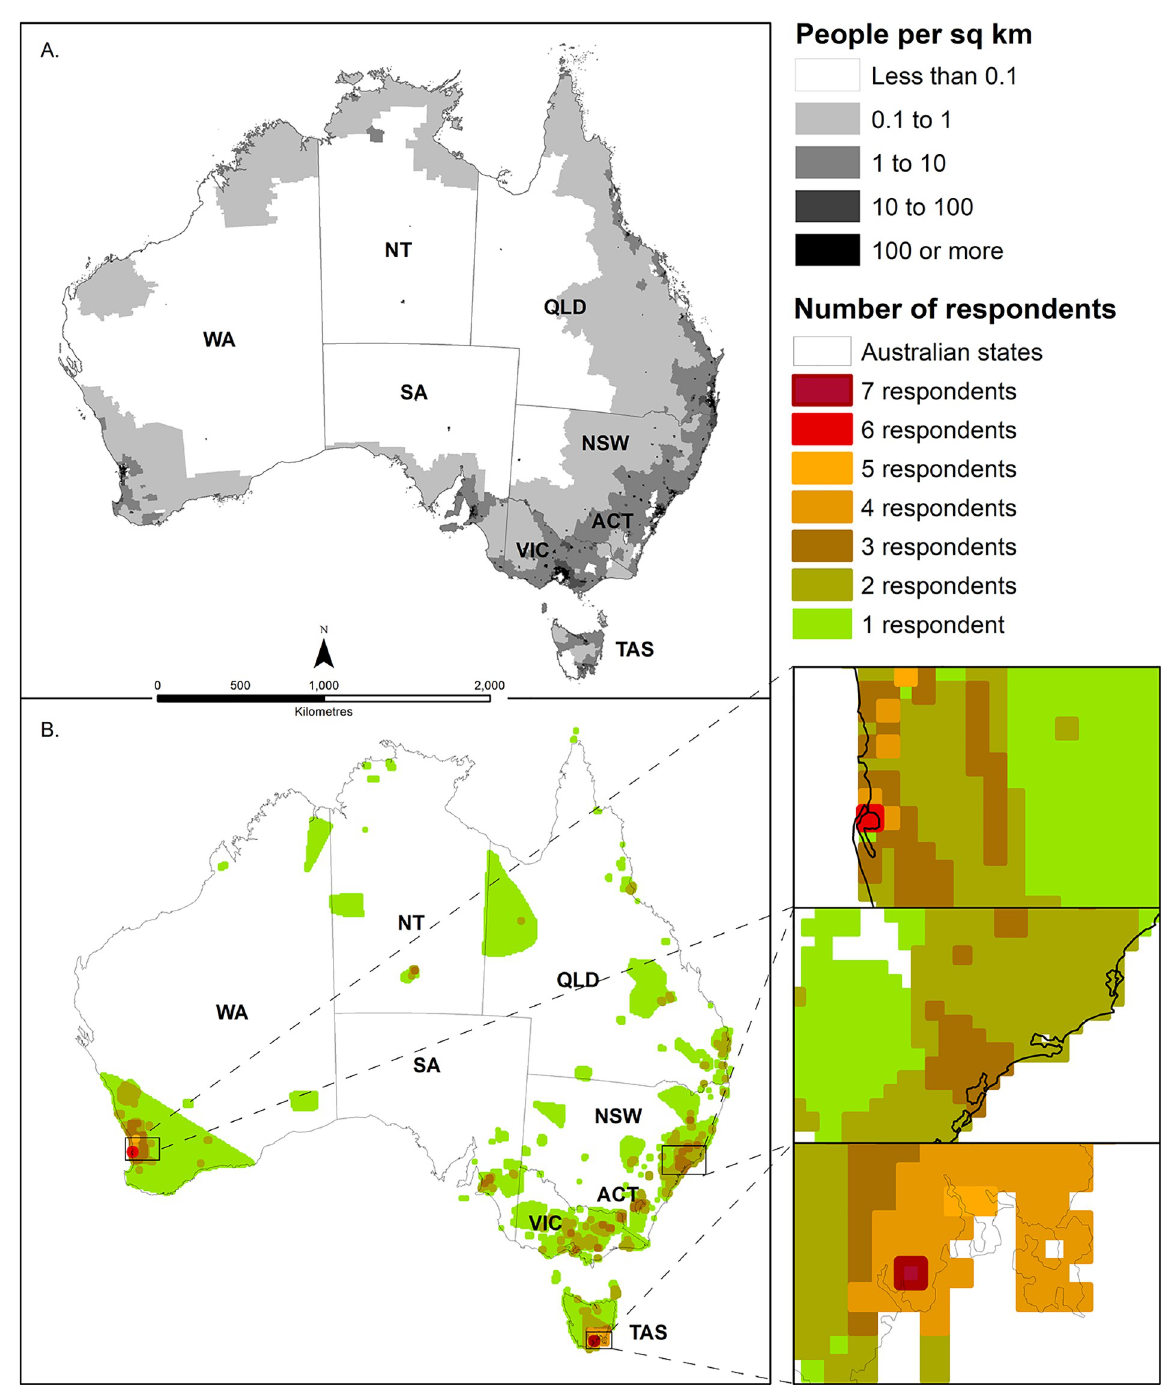
Fig 1. Distribution of respondent’s selected areas compared with Australian population densities. (a) Population density in Australia, 2016 [29], with state boundaries for Western Australia (WA), Northern Territory (NT), South Australia (SA), Queensland (QLD), New South Wales (NSW), Australian Capital Territory (ACT), Victoria (VIC) and Tasmania (TAS), (b) a heat map showing the distribution and concentration of respondents’ selected areas.